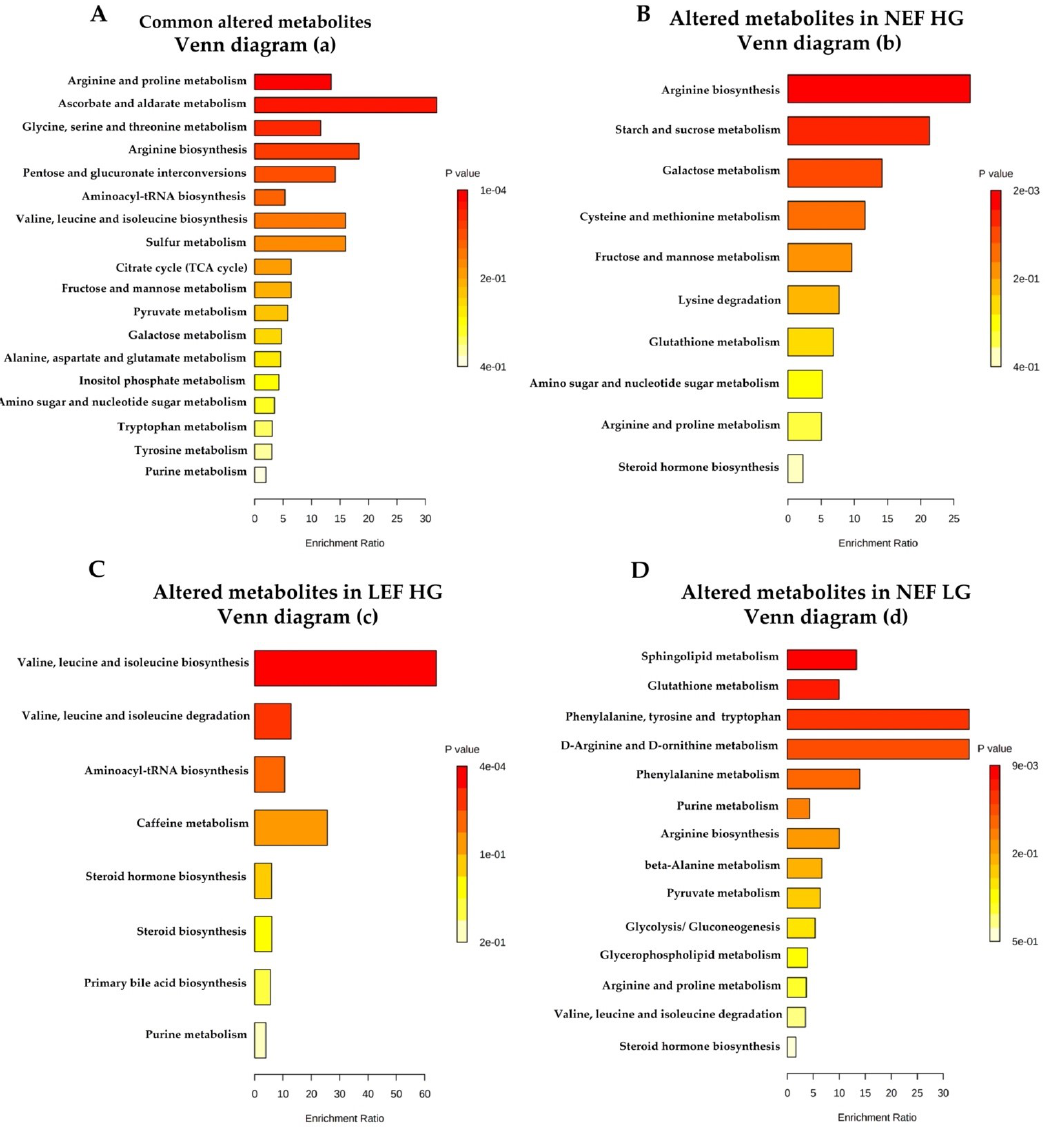
Figure 2. Pathway analysis. ( A ) The most altered functional metabolic pathways among all AS subgroups. ( B – D ) Unique altered functional metabolic pathways in each AS subgroup. The enrichment analysis was implemented using the hypergeometric test to evaluate whether a particular metabolite set is represented more than expected by chance within the given compound list. One-tailed p values are provided after adjusting for multiple testing.